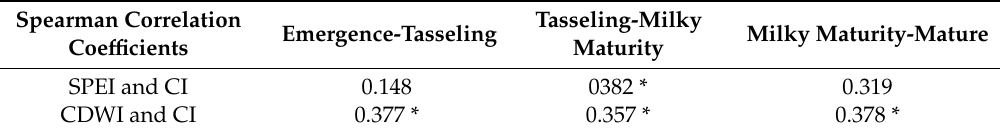
Table 6. Correlations between the CI and the two indices (SPEI and